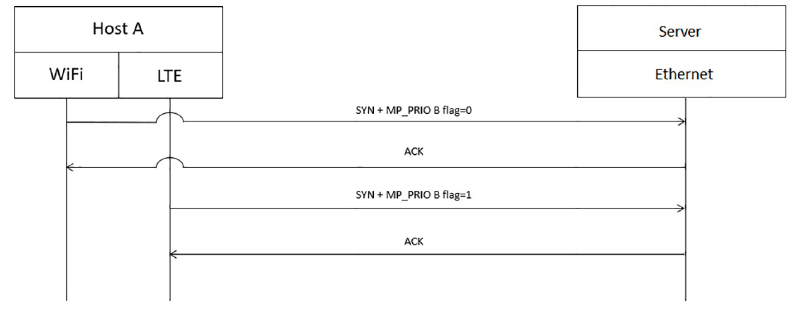
Fig 20. Use of the WiFi network as the primary network